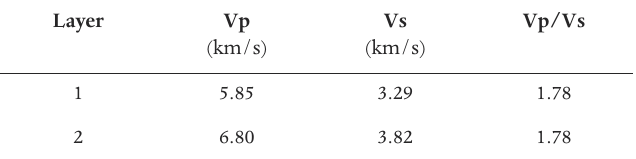
Table 1. One-dimensional model parameters. The P and S velocities, and their ratios, as illustrated in Figure 1.